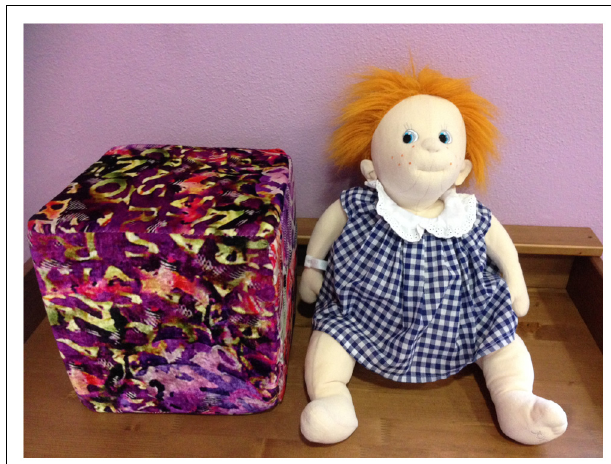
FIGURE 1 |A doll and the soft foam rubber cube used during the experimental